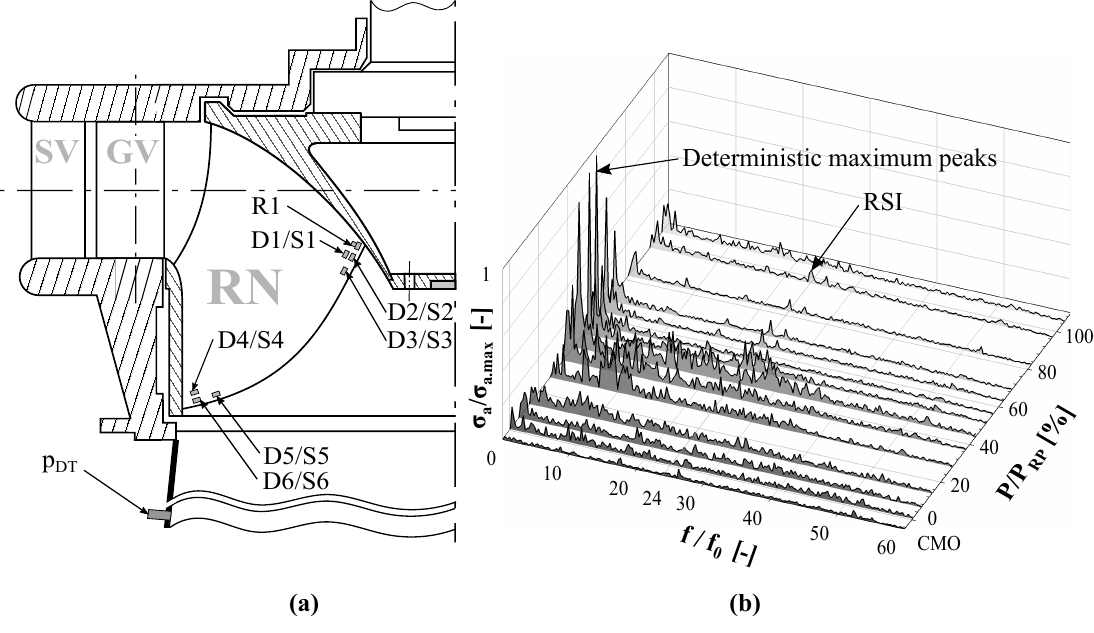
Figure 1. ( a ) meridional contour of the considered Francis turbine including strain gauge position and ( b ) waterfall chart of the sensor